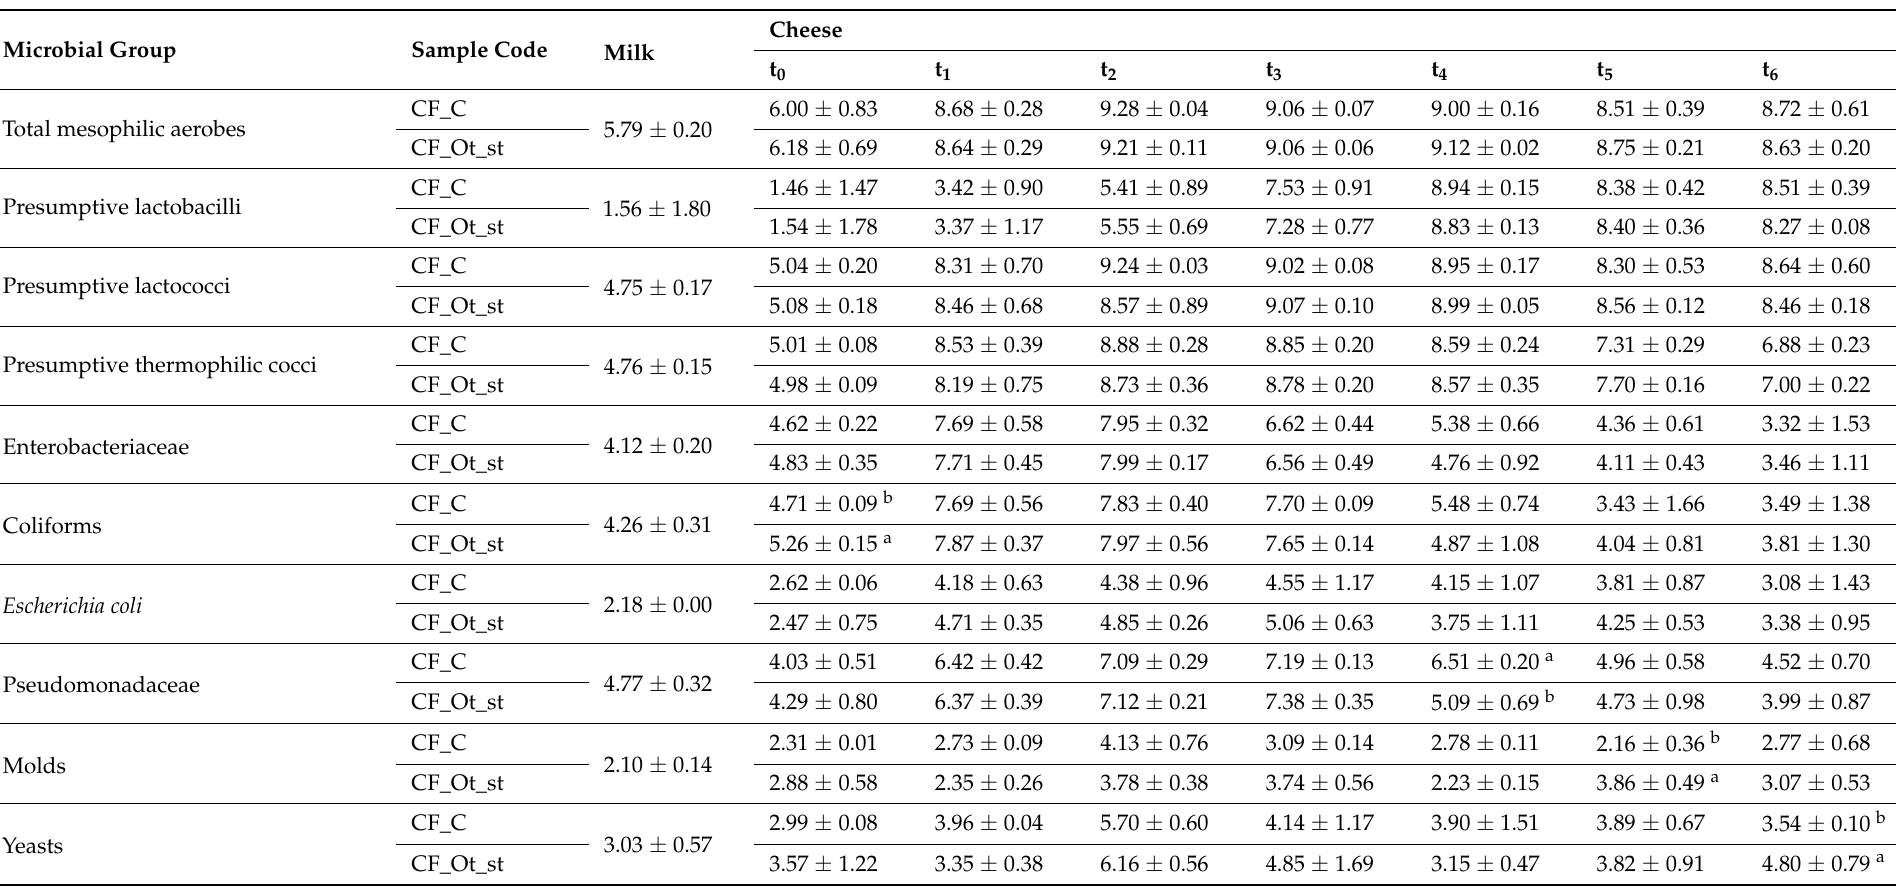
Table 2. Viable counts of milk used in the first cheesemaking round (R1_M), and control (CF_C), and experimental (CF_Ot_st) Caciofiore cheeses sampled during